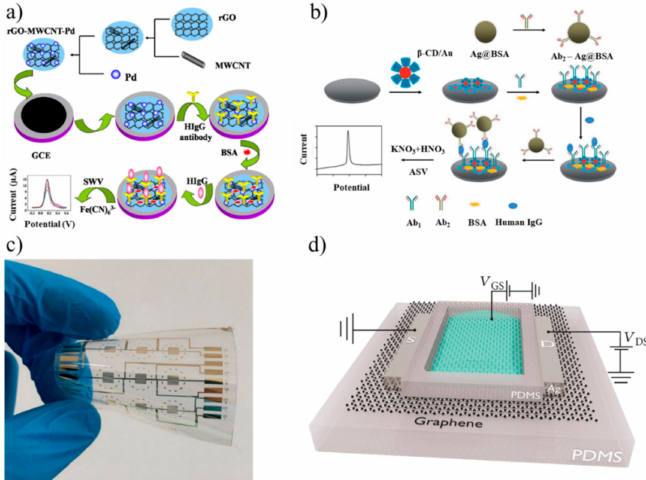
Figure 1. ( a ) Fabrication of an immunosensor for immunoglobulin G (IgG) using a reduced